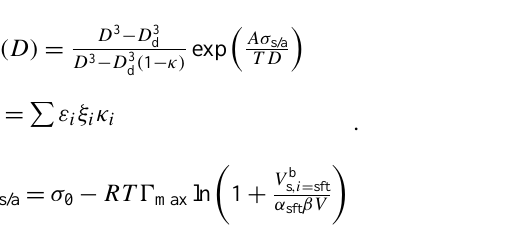
Table 1. Physicochemical properties of sodium-dodecyl